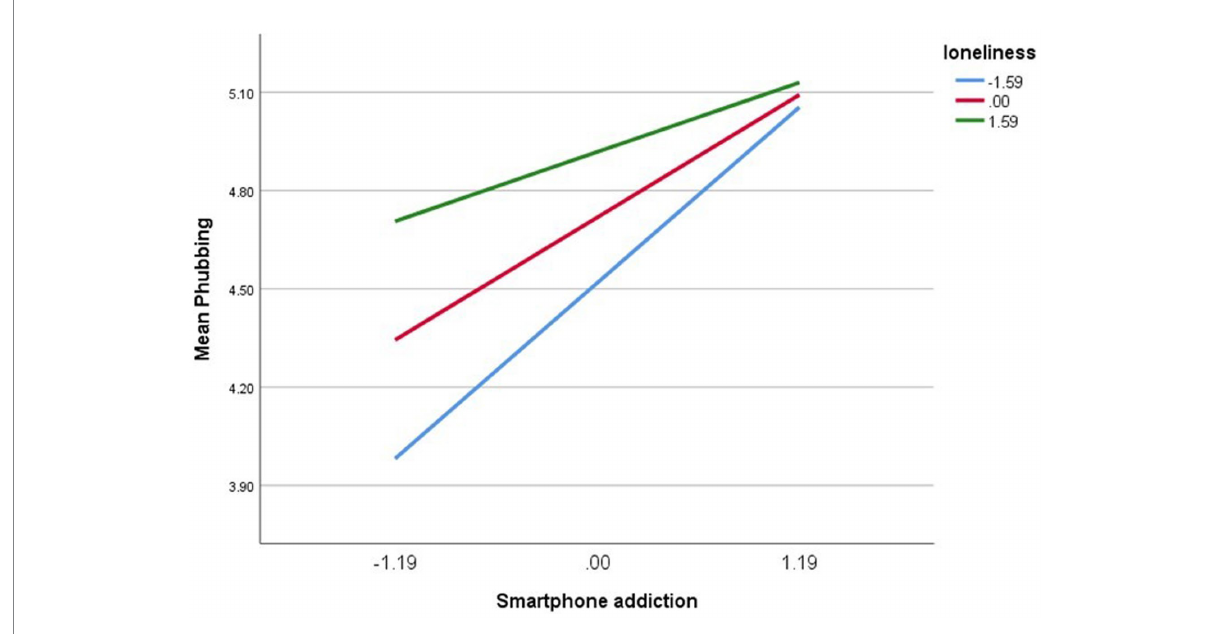
FIGURE 4 The moderating impact of loneliness on the relationship between SMA and